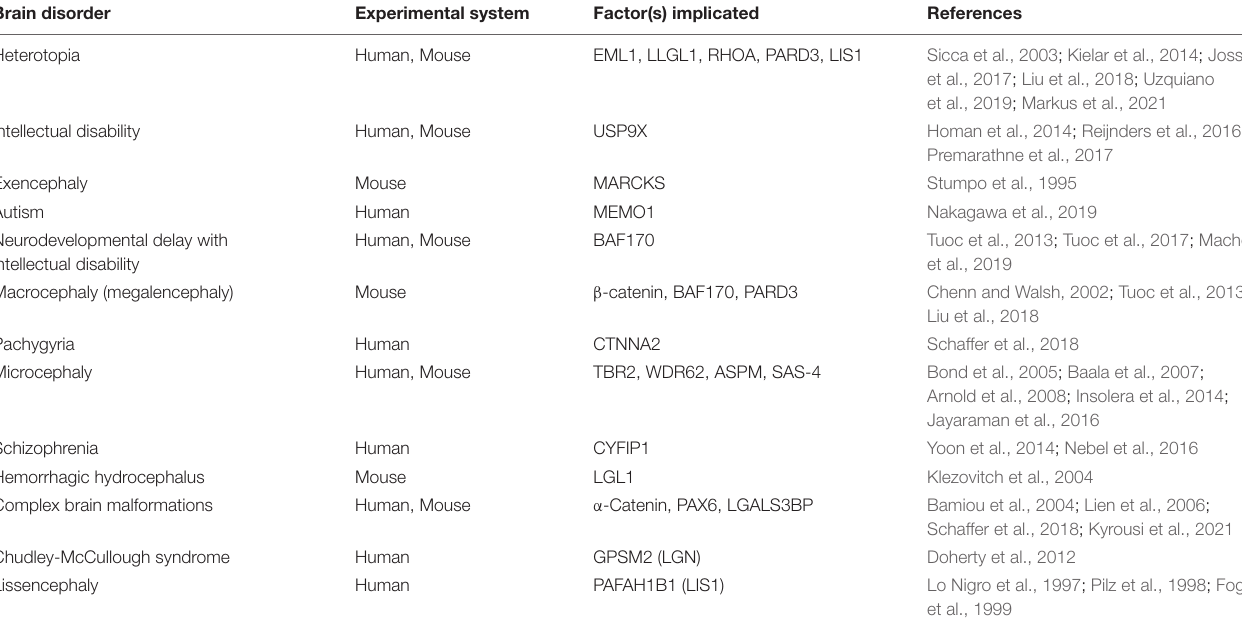
TABLE 1 | Neurological and neurodevelopmental disorders associated with dysfunction of delamination-related factors. Brain